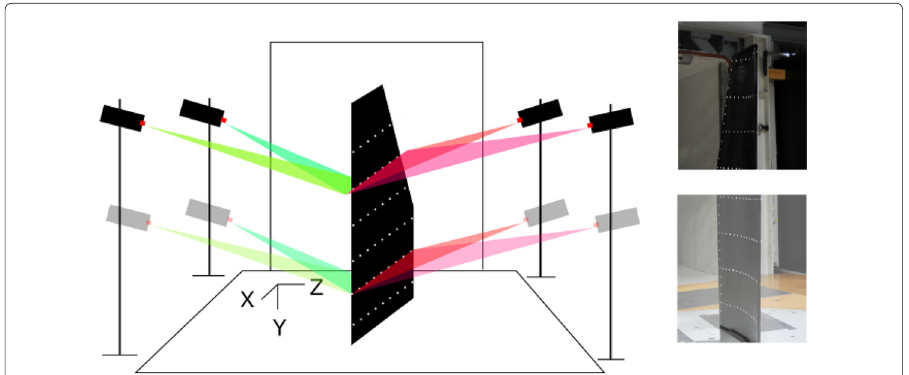
Fig. 4 Sketch explaining the two operations during a photogrammetry